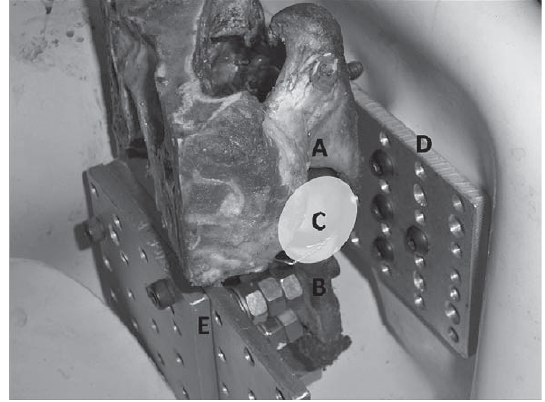
Fig.3. Aswinespecimensittingwithinthemechanism.(A)Thetem- poral portion of the skull, with the temporal fossa located directly below the “A”. (B) The mandible with the mandibular condyle located at “C”. (C) The location of the implant. (D) The bracket that attaches to the temporal portion of the skull through the zygo- matic arch. The active end of the horizontal linear actuator (Fig. 1) attaches to the other side of this bracket. (E) This bracket attaches to the mandible and was fastened on top of the compression piston (Fig. 1). Surrounding the attachment plates and specimen is the pure gum rubber sac that confined the saline bath during